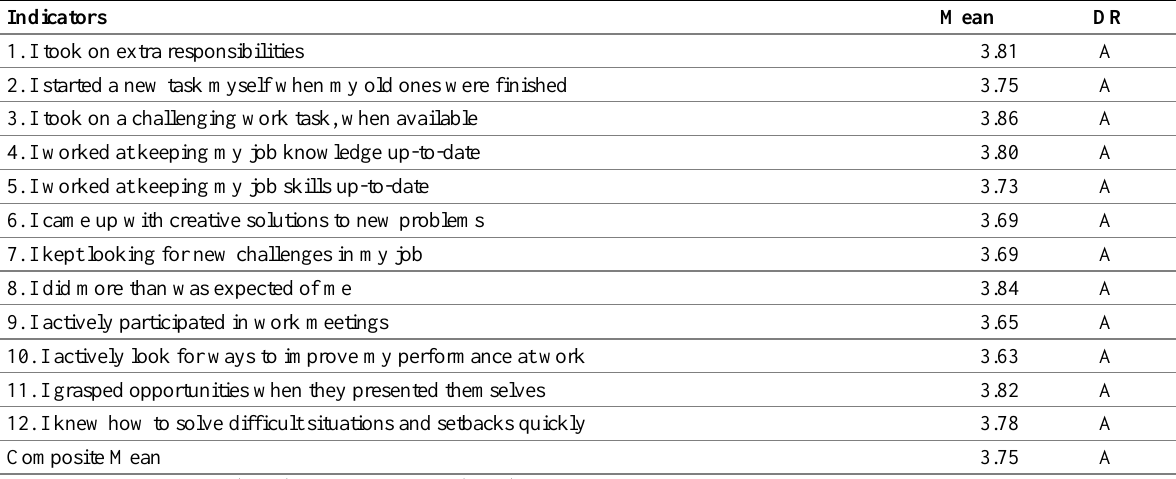
Table 8: Individual Work Performance of Employees in terms of Contextual